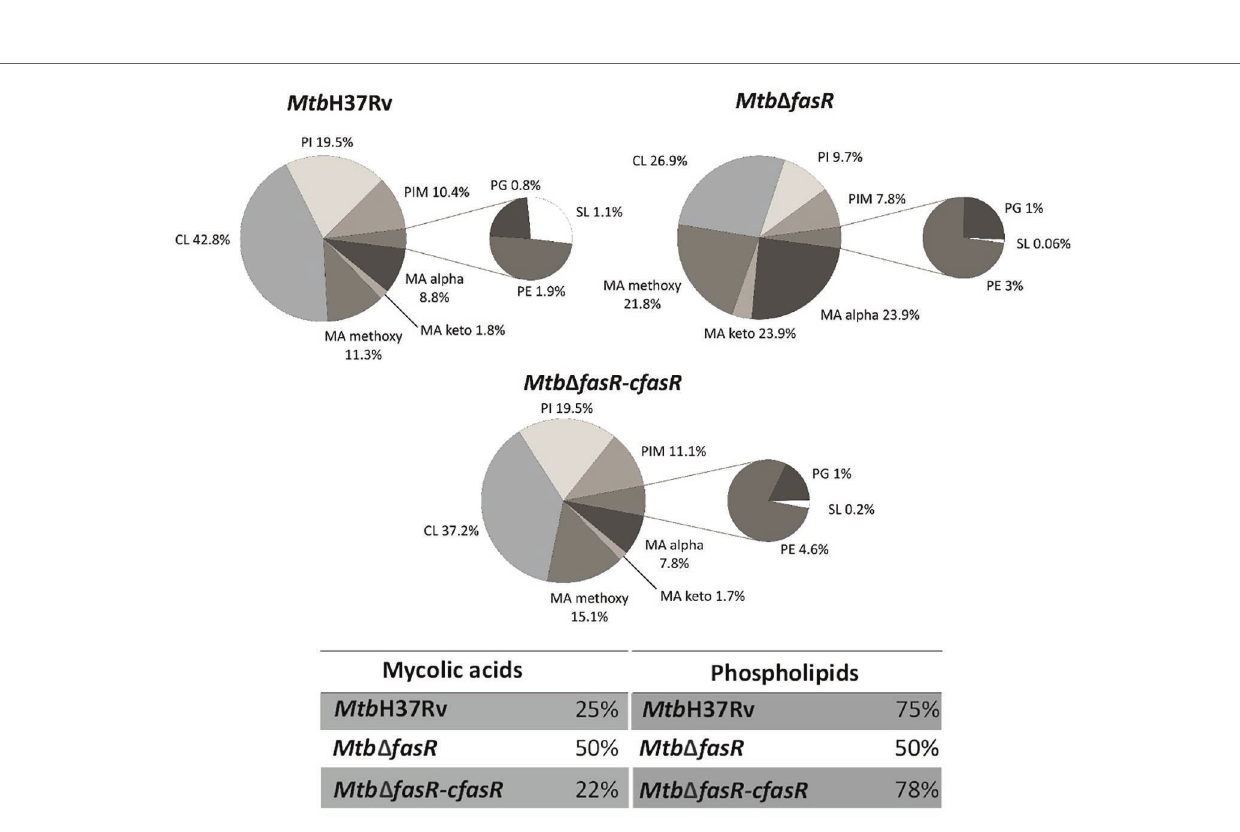
FIGURE 4 | Lipid profile in positive ion mode. LC-MS analyses (positive mode) of lipids present in M. tuberculosis wild type strain ( Mtb H37Rv), fasR complemented strain ( Mtb ∆ fasR -c fasR ), and fasR KO strain ( Mtb ∆ fasR ). The values indicated represent the relative abundance of the MS signals corresponding to the different lipid classes found in the samples. Results are the means of three independent experiments. TAG, triacylglycerol; DAG, diacylglycerol; MMDAG, monomycolyl DAG; PDIM, phthiocerol dimycocerosates; GroMM, glycerol monomycolate; TMM, trehalose